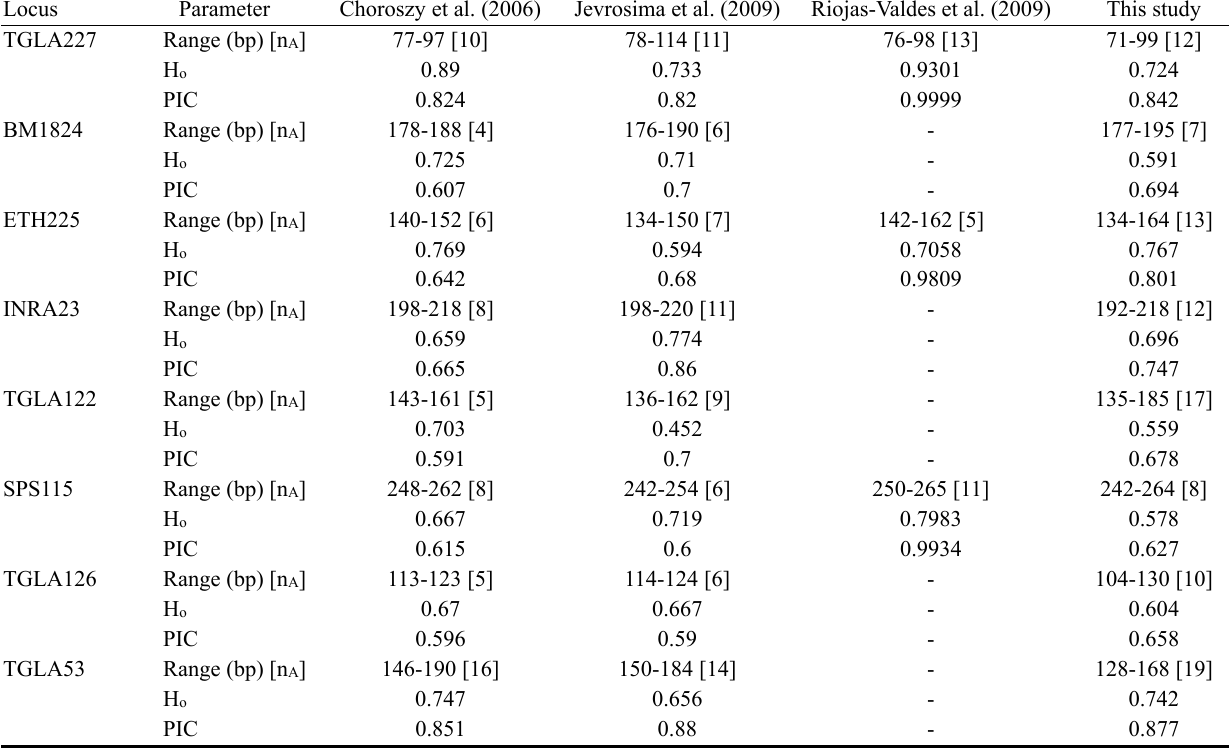
Table 3. Comparison of size range of microsatellite alleles in Simmental cattle Locus